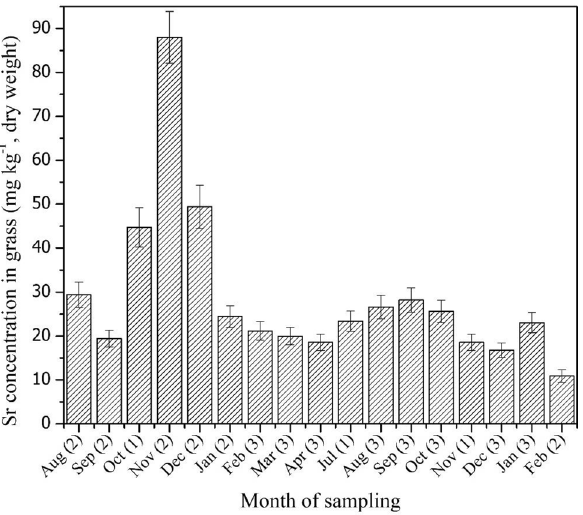
Figure 2. Monthly variation of stable Sr concentration in the grass (experimental field). The number of samples analyzed for each month is given in the